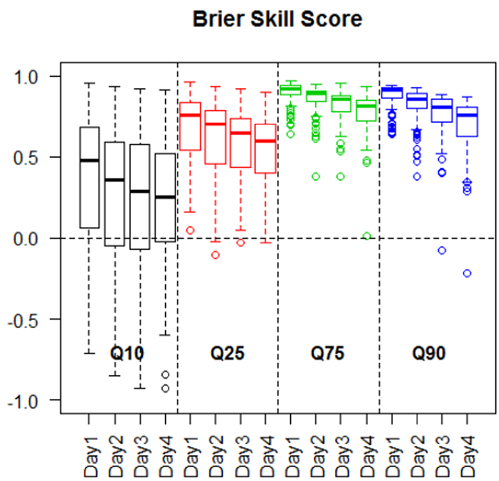
Figure 14. BSS for the best-performing joint predictor at each gauge for different lead times and event thresholds. The BSS’ per- fect score equals one. A BSS of zero indicates a forecast without